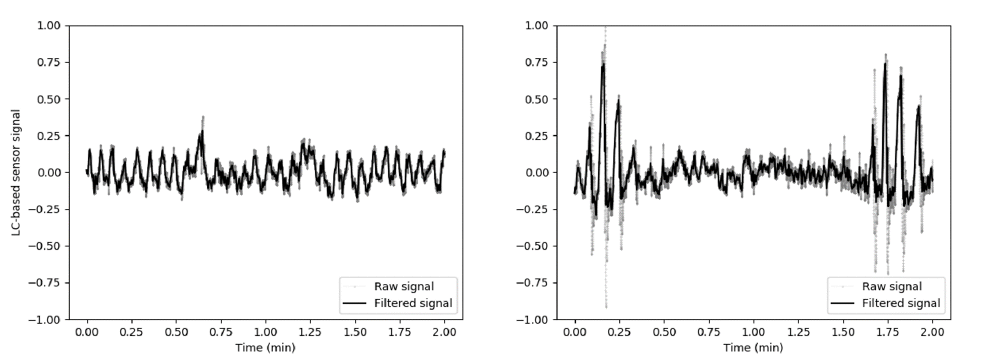
Figure 3. Examples of signals obtained from our load cell (LC)-based sensing